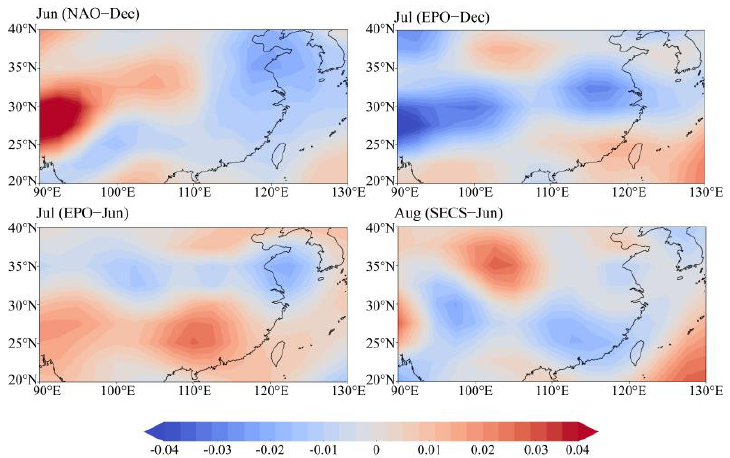
Figure 10. Difference in water vapor vertical velocity fields (unit: Pa/s) between summers with the high and low SST years.